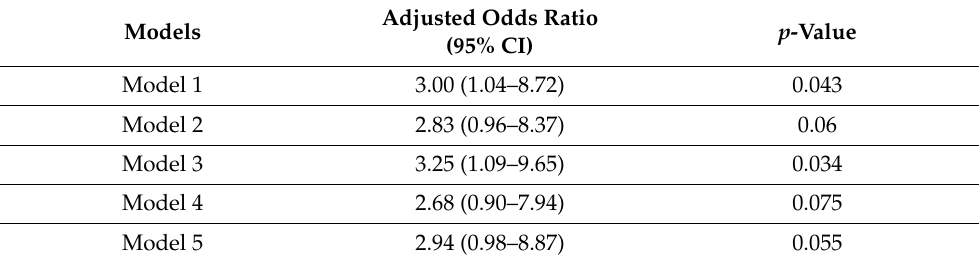
Table 2. Probability for improvement in knowledge in the intervention group vs. the control group controlling for socio-demographic factors. Results from multivariate logistic regression models. Models